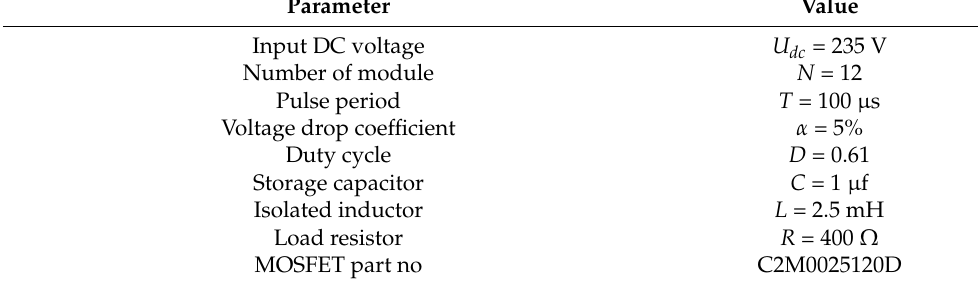
Table 3. Proposed topology experiment parameter for 10 kV pulse.